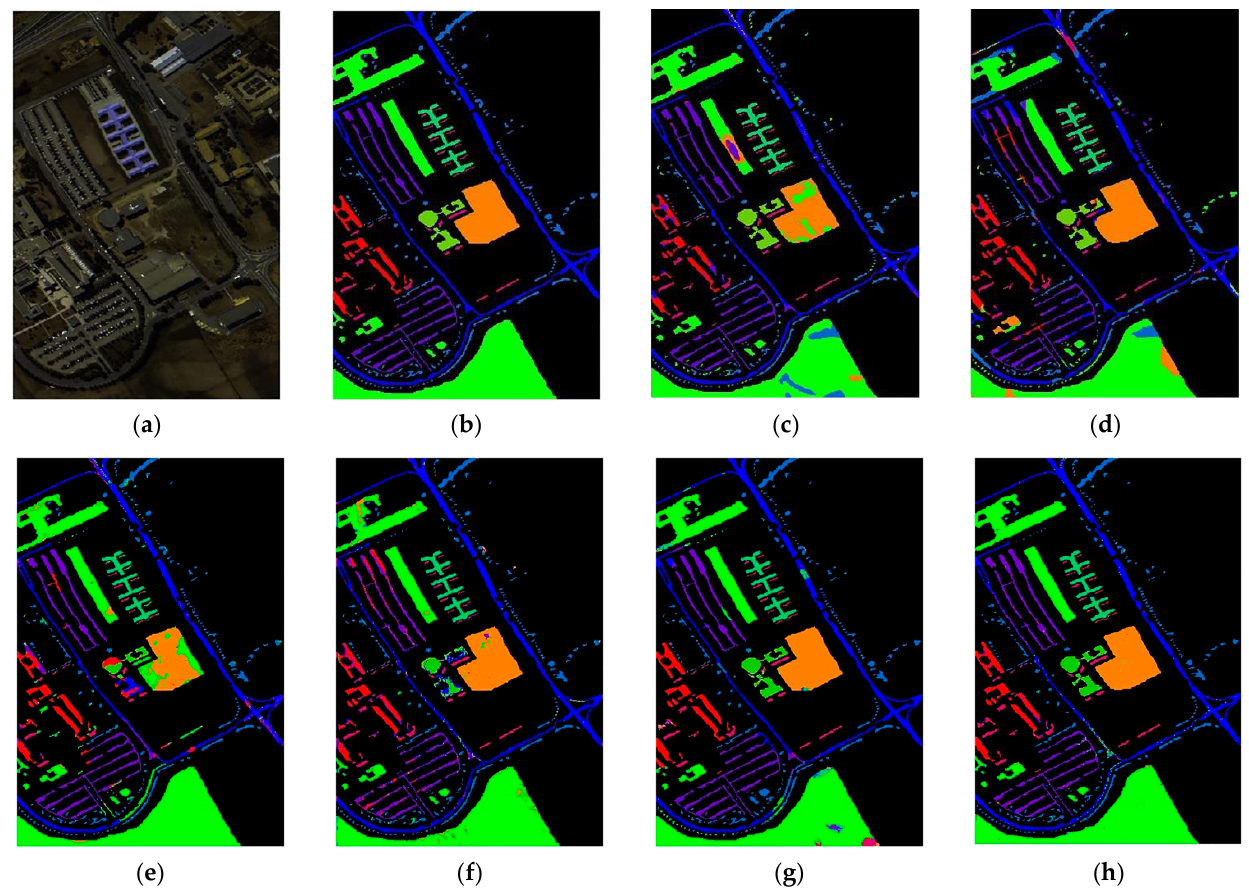
Figure 9. C Pavia University dataset Classification: ( a ) False color image, ( b ) Ground-truth map, ( c ) EPF, ( d ) IFRF, ( e ) RPNET, ( f ) CNN-AL, ( g ) SS-RMG, ( h ) Table 7. Classification results of different methods on the Pavia University dataset.